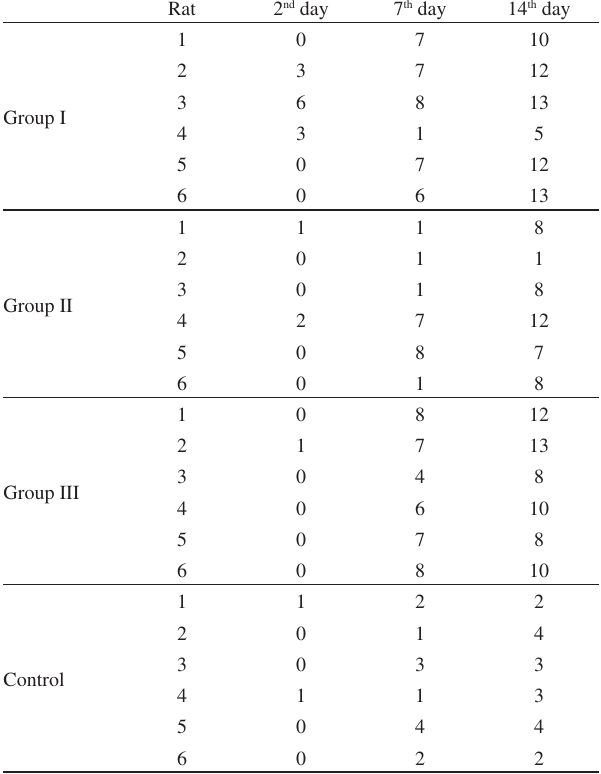
Table 1 - Functional evaluations on the second, seventh and fourteenth days following the spinal injury